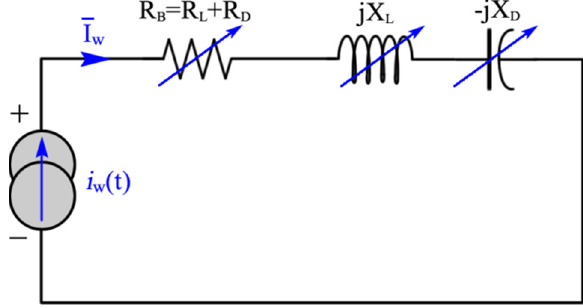
Figure 13. Electric equivalent circuit for a blade that is subject to a wind